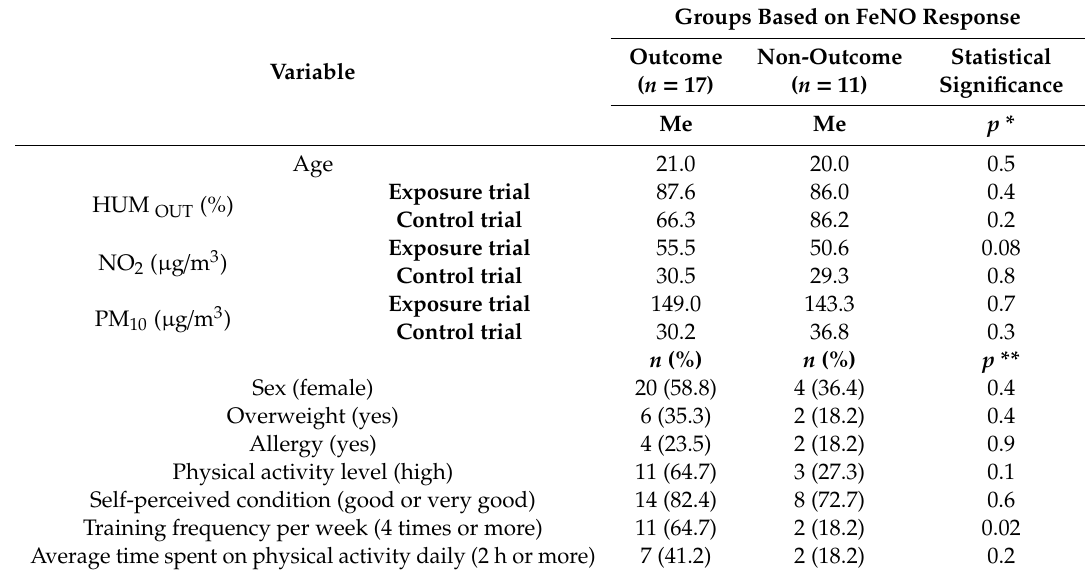
Table 6. Comparison of the outcome and non-outcome groups based on FeNO response. Groups Based on FeNO Variable